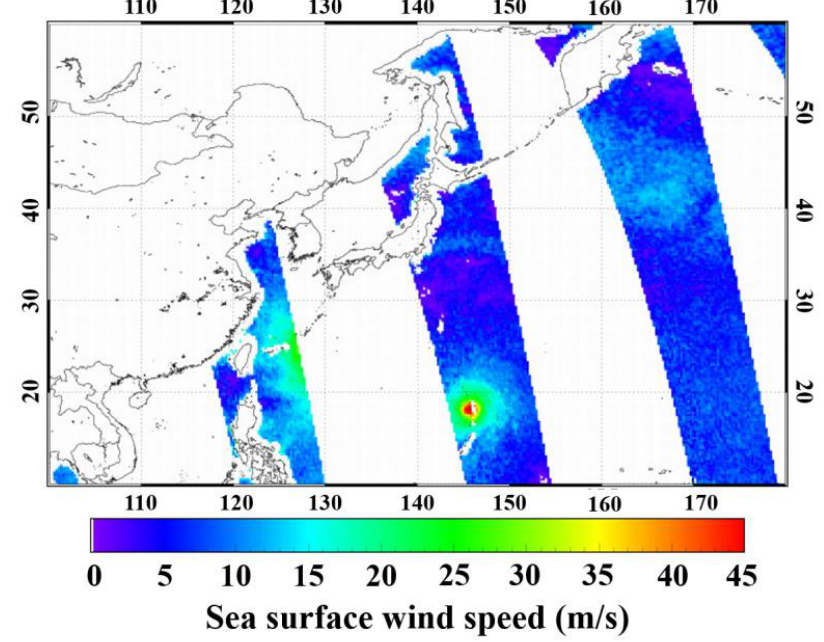
Figure 1. An example of a typhoon observed by Soil Moisture Active Passive (SMAP) sea surface wind speed retrievals on 9 July